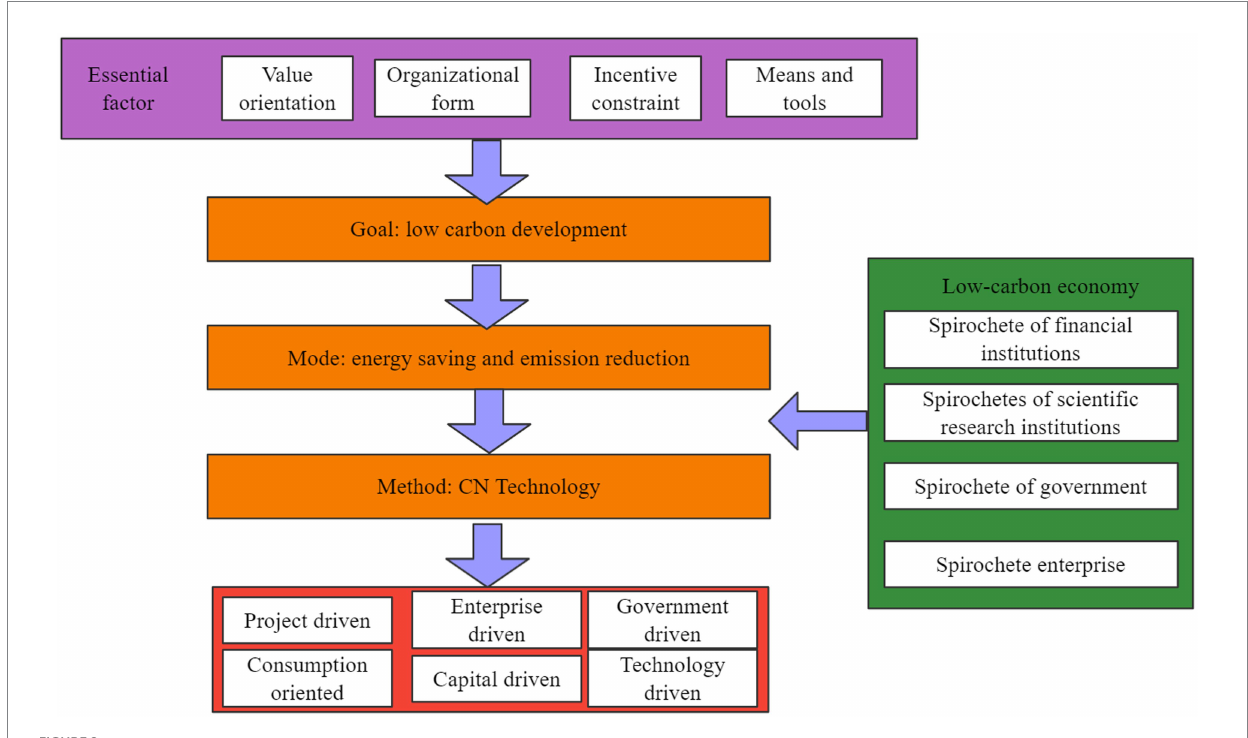
FIGURE 2 Low-carbon economic development model